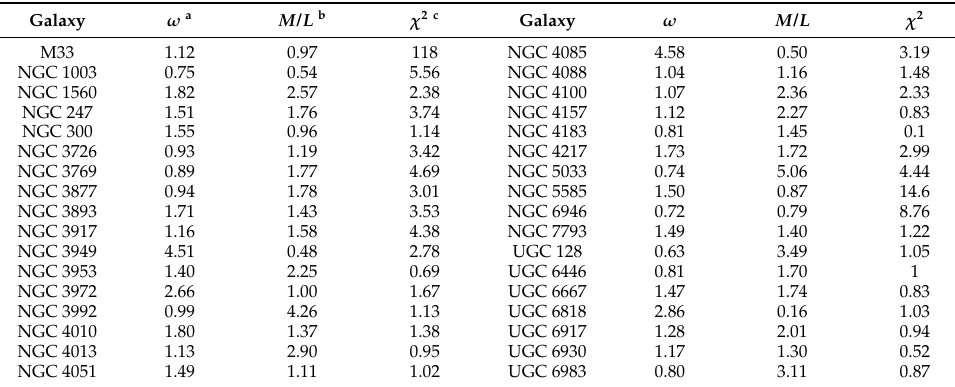
Table A1. The best-fit M / L and ω for each galaxy.